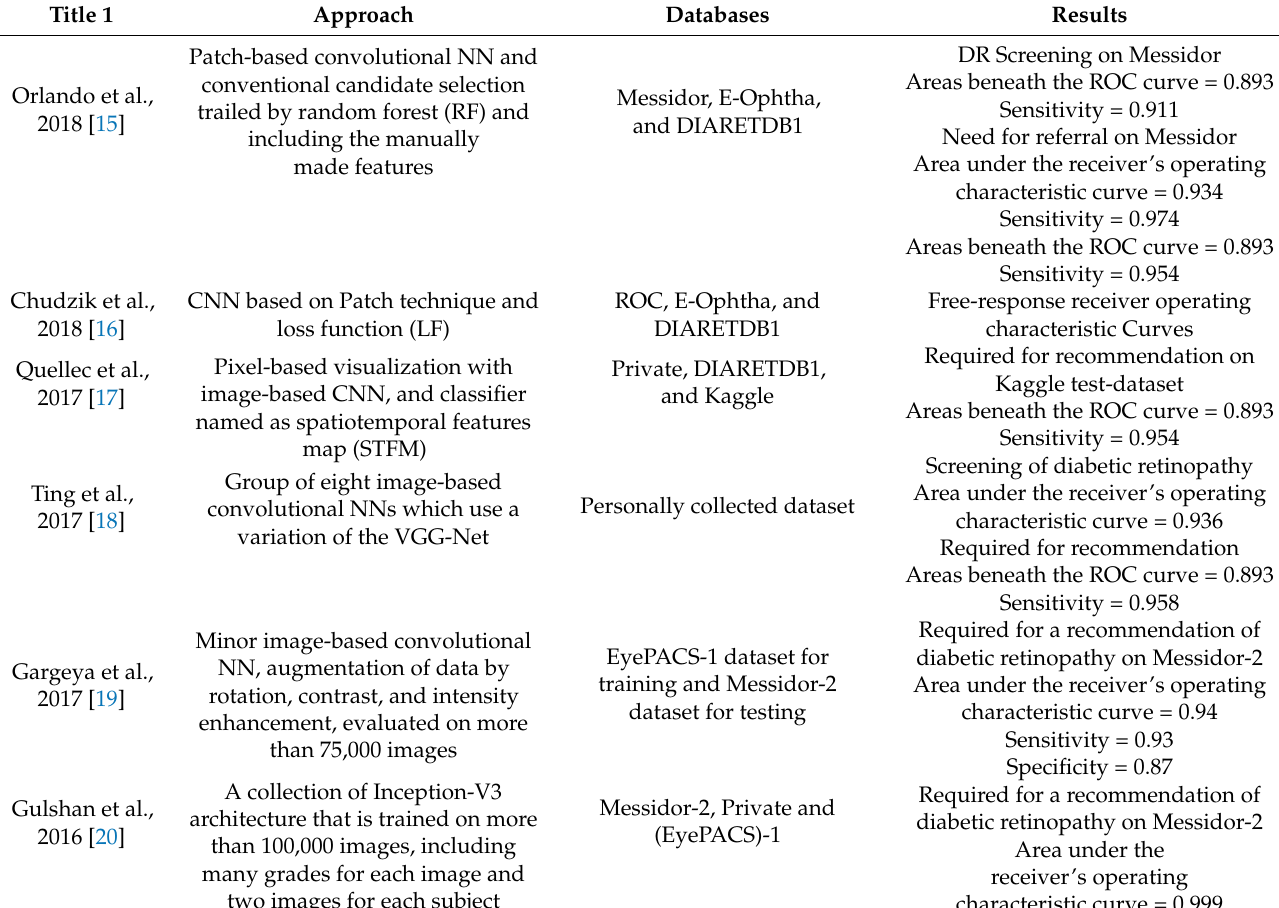
Table 1. Studies that implement deep learning techniques for the detection of DR.